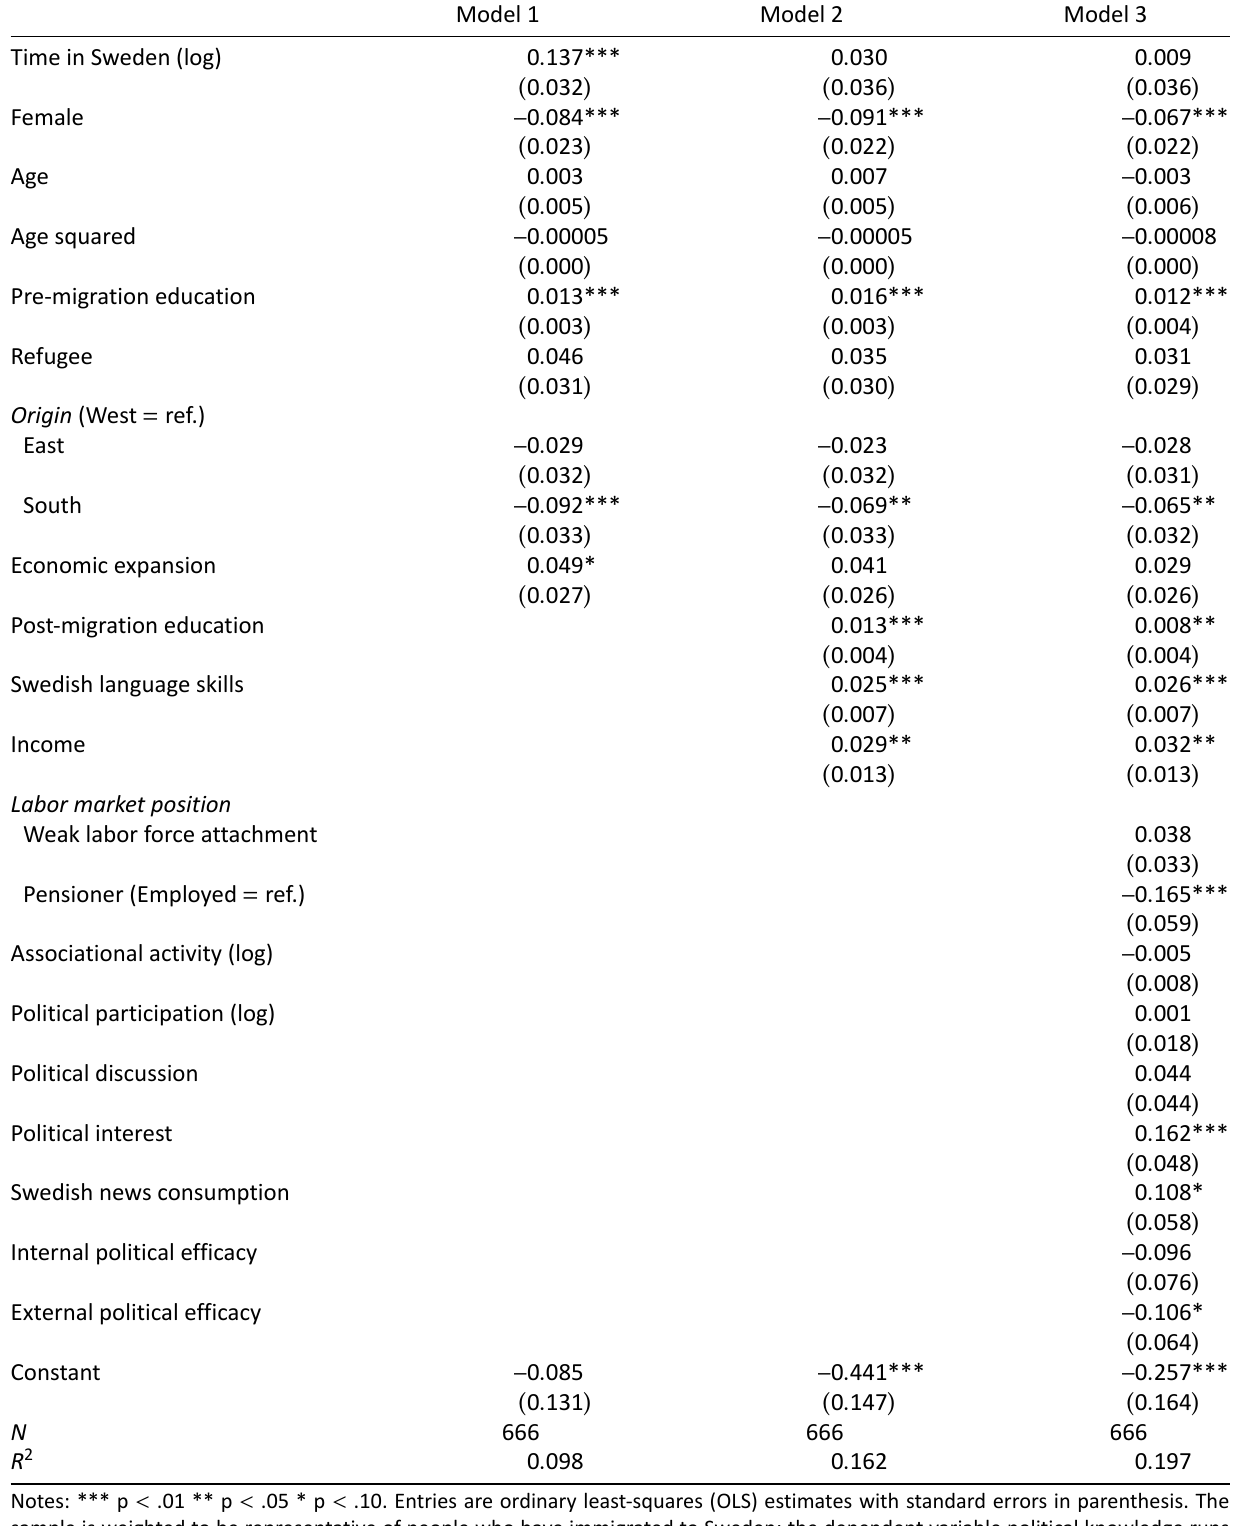
Table 1. Predicting political knowledge (0–1) among immigrants in Sweden, considering time-related differences and abil- ity, motivational, and opportunity